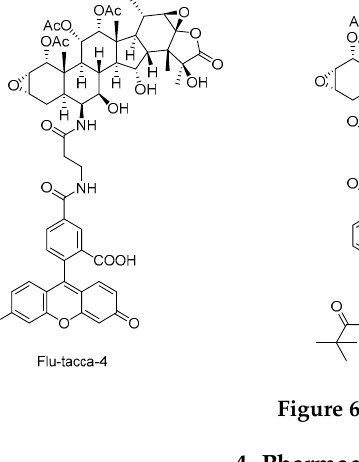
Figure 5. Structure-activity relationships (SARs) of reported taccalonolides. These SARs are observed as well by computational analysis such as i) taccalonolides covalently bind to β -tubulin D226 via the C22–C23 epoxide group, and ii) the bulky group at C-1 is involved in interactions with β -tubulin residues through hydrogen bonds [17,18,45]. According to established SARs, a group of taccalonolides with a fluorescein group at C-6 such as Flu-tacca-4, Flu-tacca-5, Flu-tacca-7, and Flu-tacca-8 were designed and generated to facilitate the identification of binding site interactions, among which Flu-tacca-7 showed comparable potencies in the proliferation of HeLa and SK-OV-3 cells (Figure 6) [18,46].